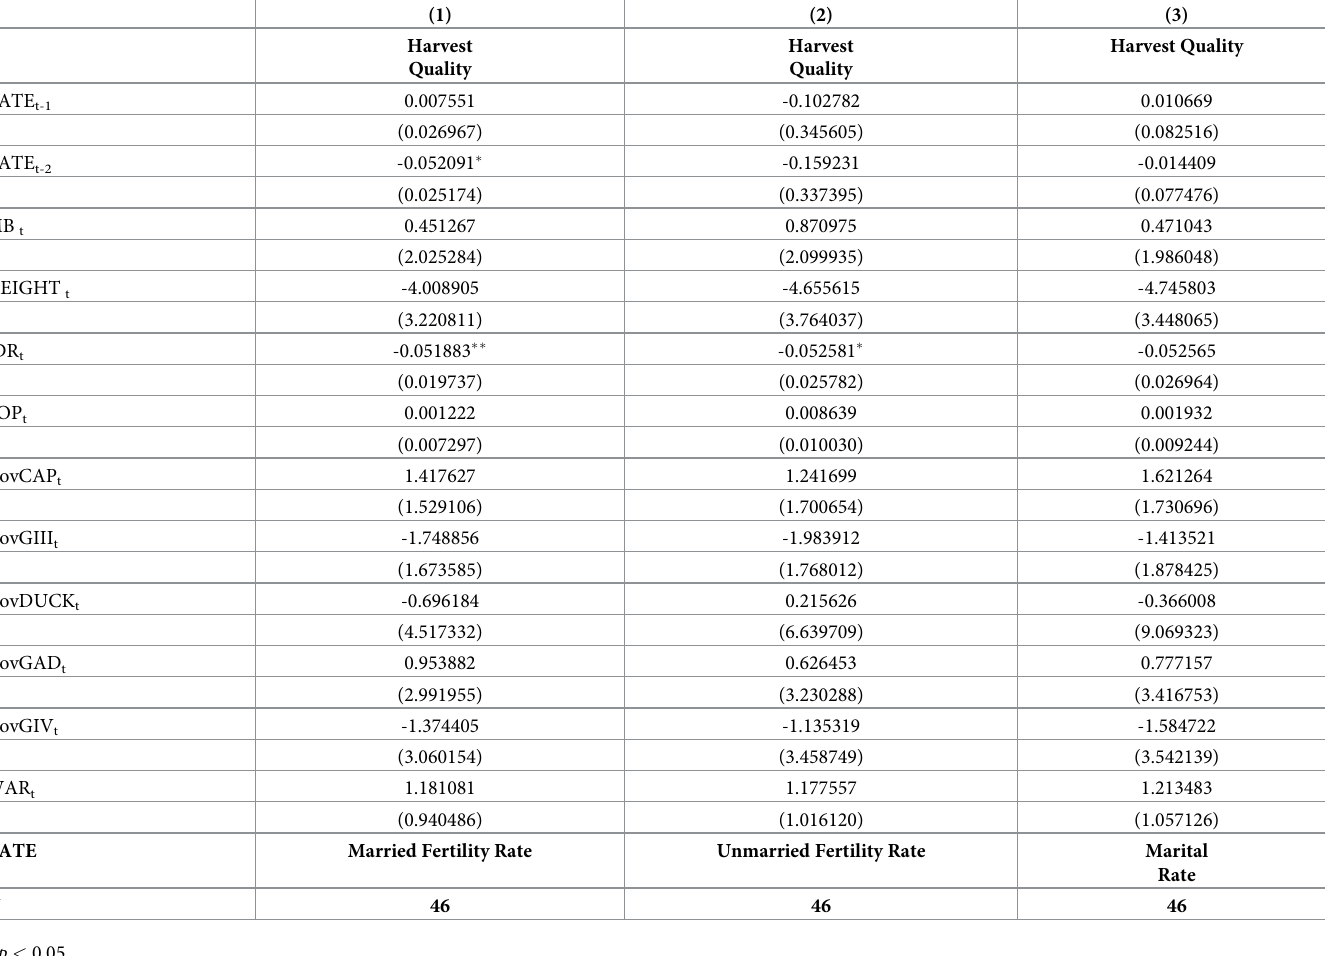
Table 4. Robustness checks show that prior fertility and marriage rates did not exhibit positive relationships with the bounty of future annual harvests in 18 th cen- tury